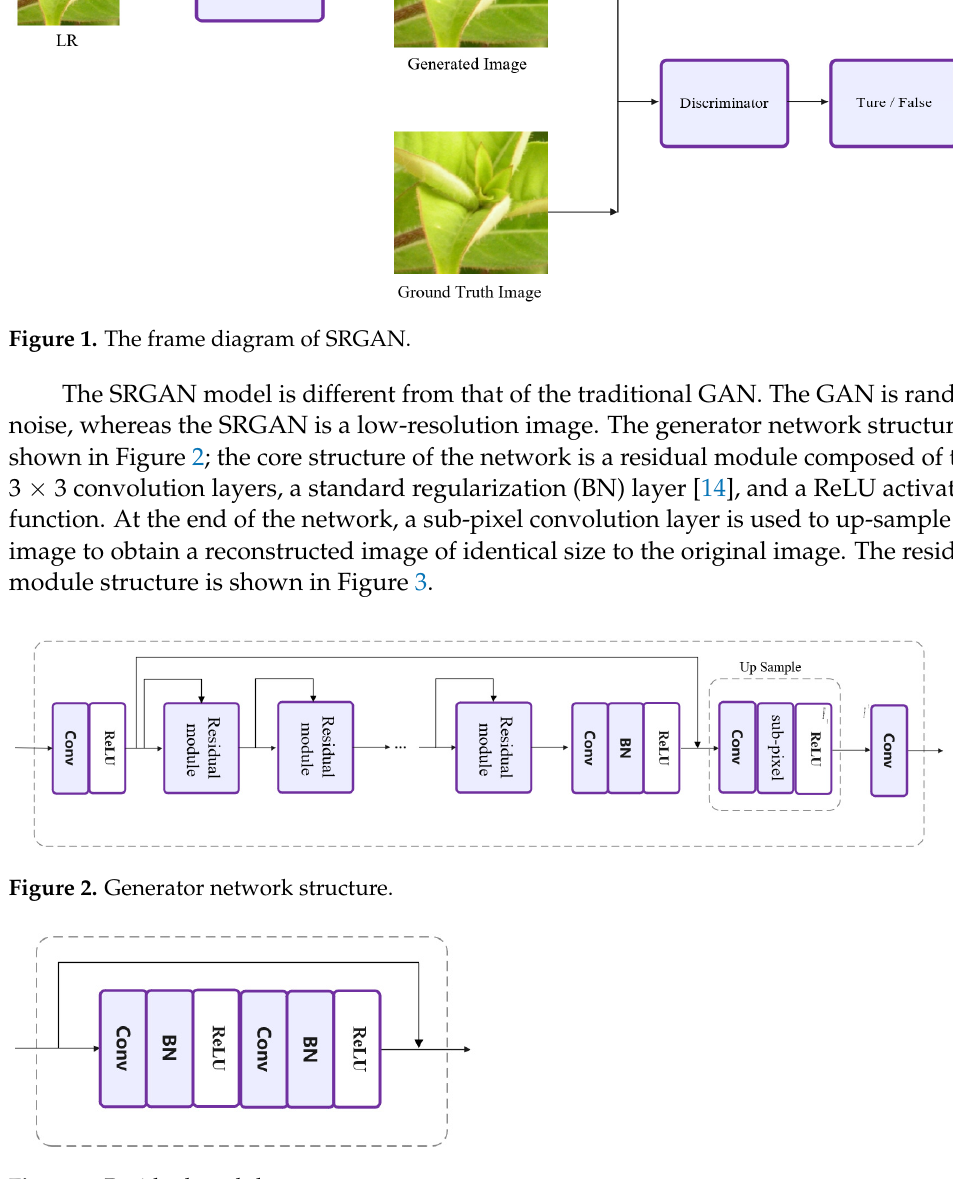
Figure 3. Residual module structure.